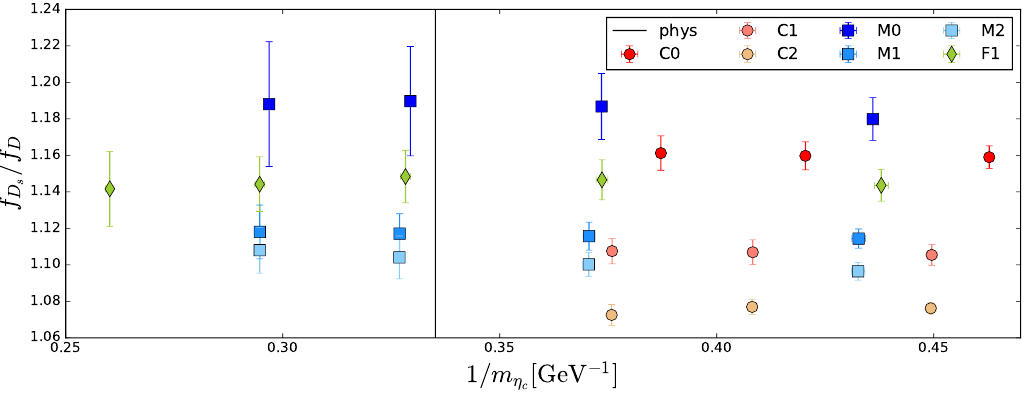
=f D as obtained from the correlator s